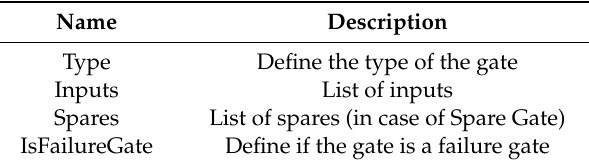
Table A7. Marking of the components of the hybrid basic events HBE1 and HBE5 (refer to Figure 4).